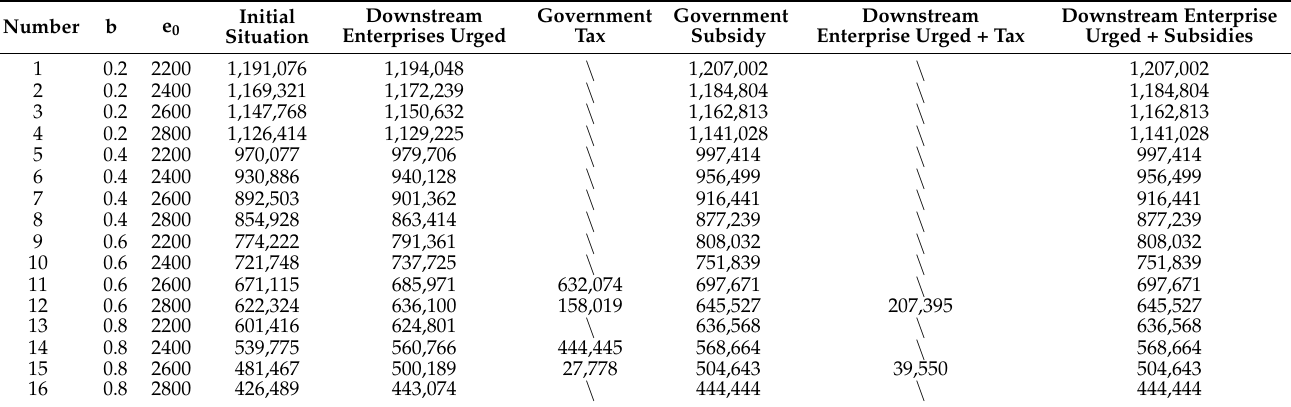
Table 2. Profit of suppliers.